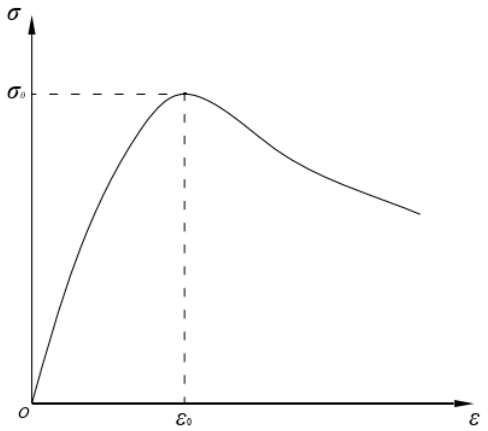
Figure 6. Stress–strain model of core concrete.